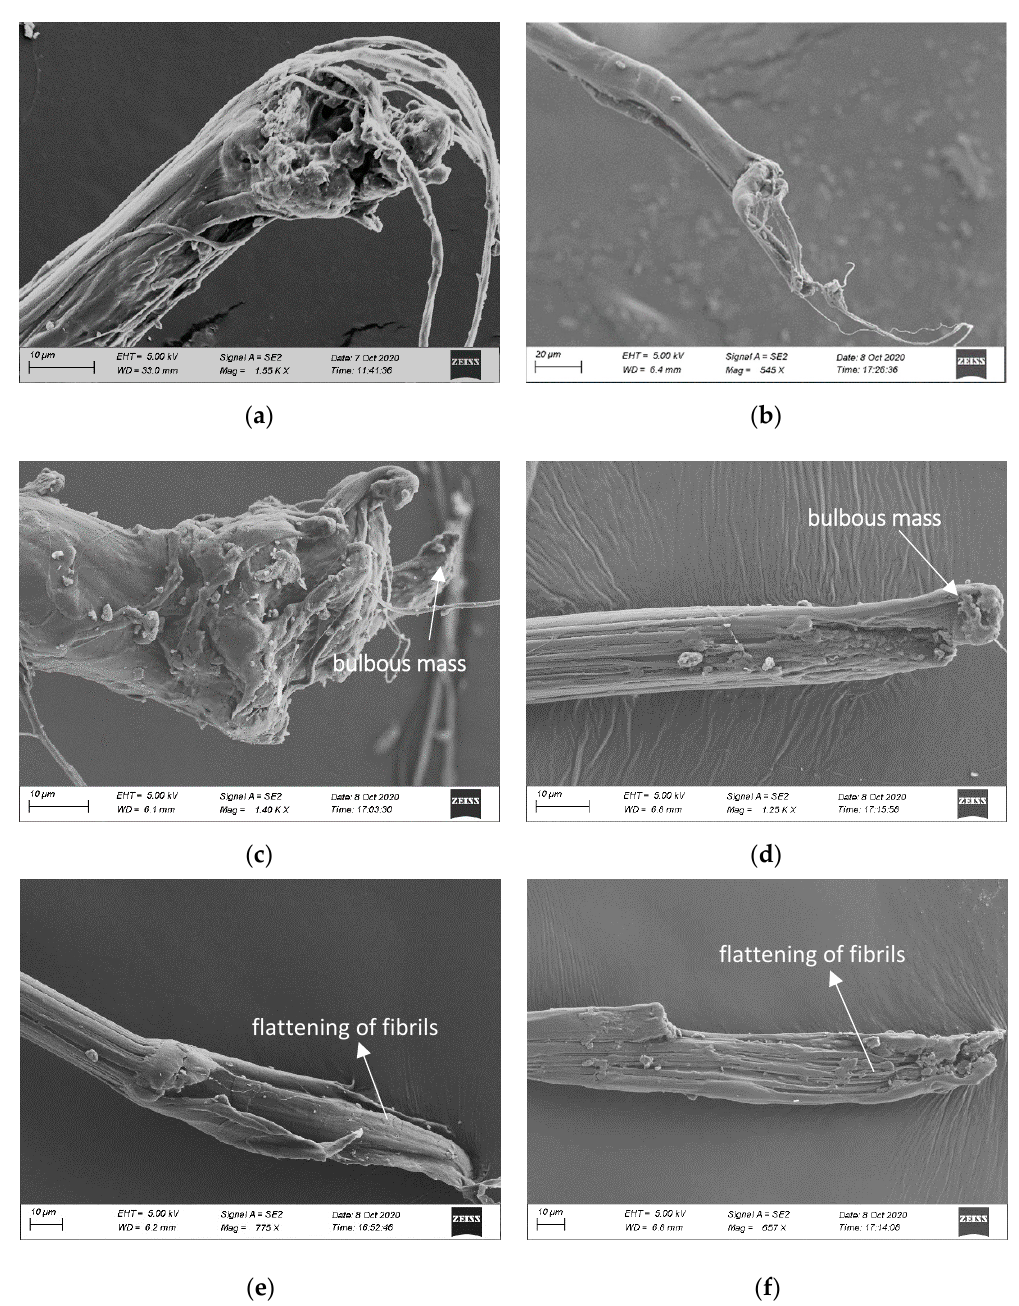
Figure 5. SEM image of fiber fracture surface: ( a , c , e ) for the round projectile and ( b , d , f ) for the 200-micron indenter.